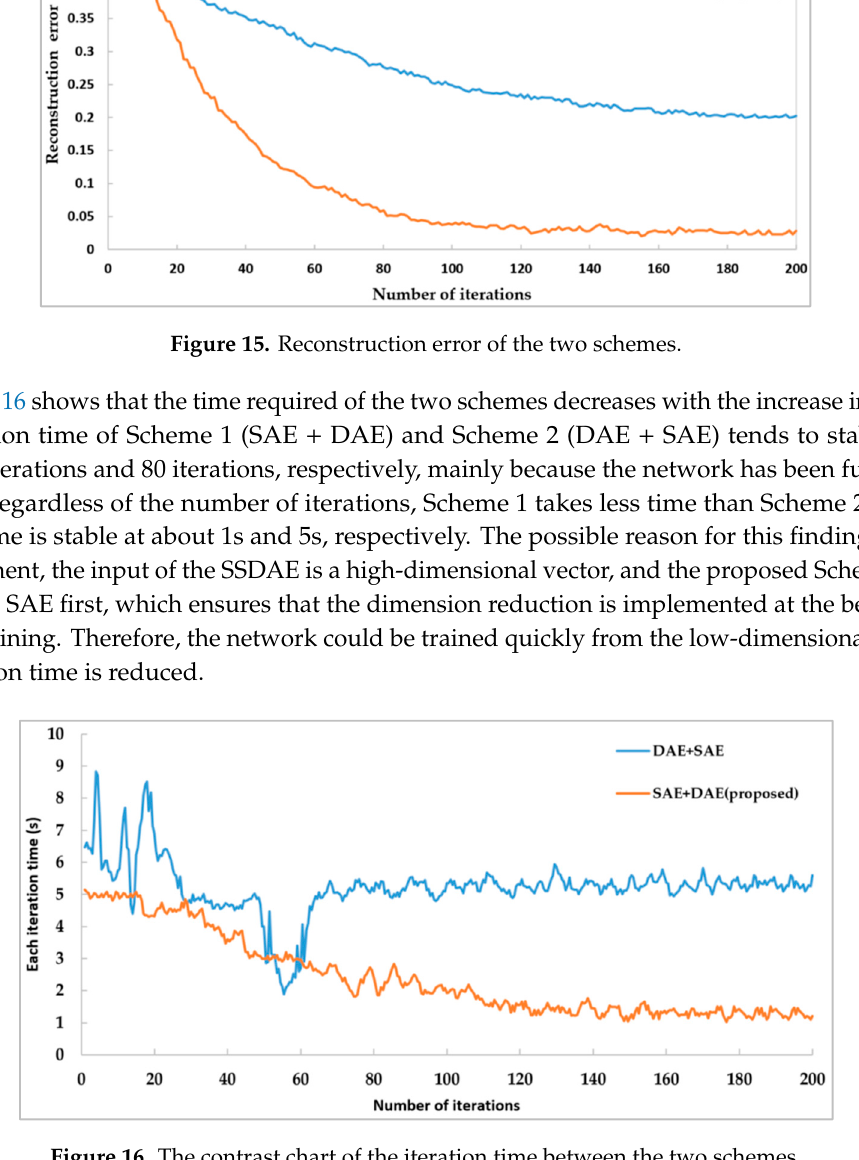
Figure 16. The contrast chart of the iteration time between the two schemes.